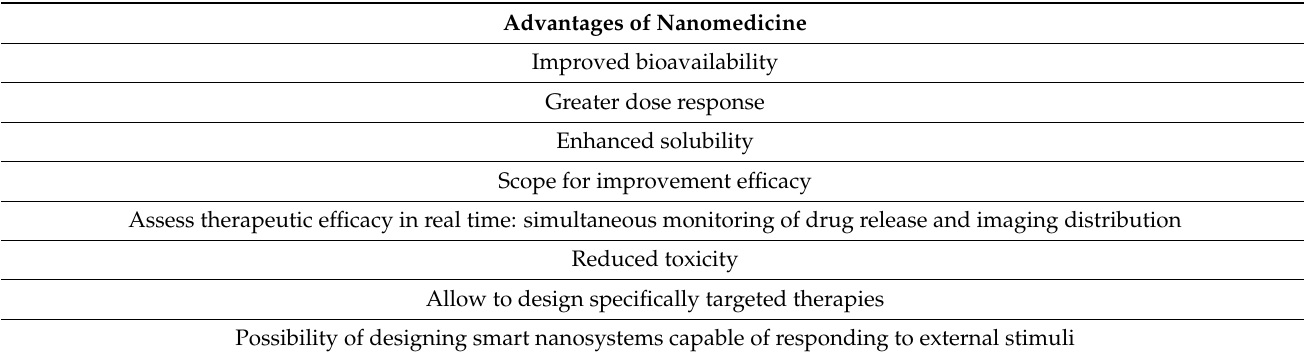
Table 1. Advantages of nanomedicine compared to conventional chemotherapeutics.